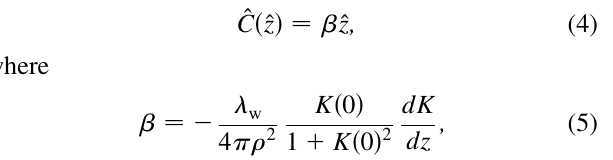
FIG. 1. Conceptual scheme for obtaining circular polarization at x-ray